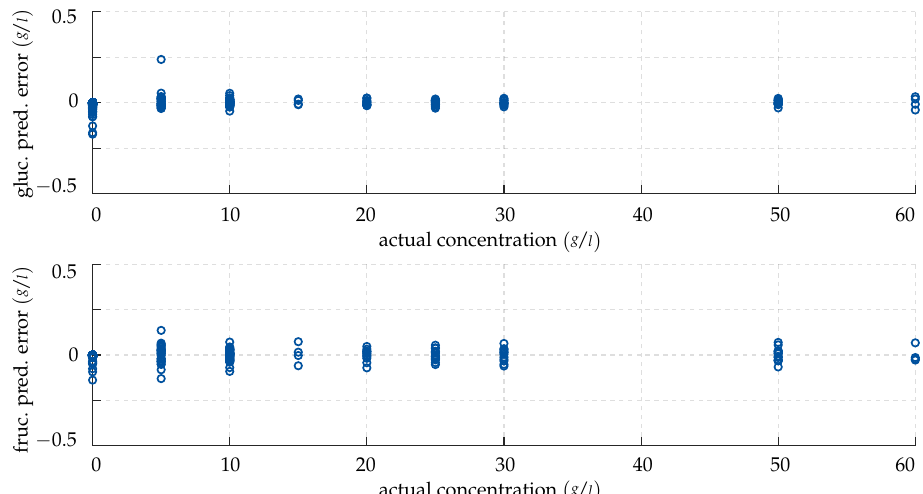
Figure 10. Prediction error made by the GPR for the training data. ( Top panel ) deviation in the predicted glucose concentration plotted over the actual concentration. ( Bottom panel ) deviation in the predicted fructose concentration plotted over the actual concentration.